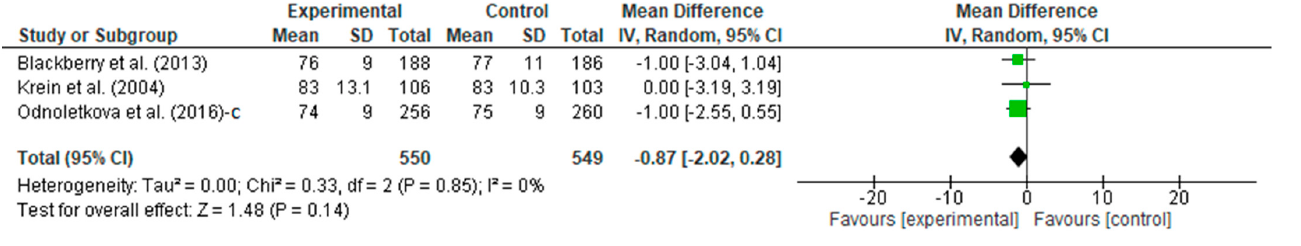
Figure 8. Forest plot intervention vs. control of telecoaching in achieving a DBP outcome [12,18,21].